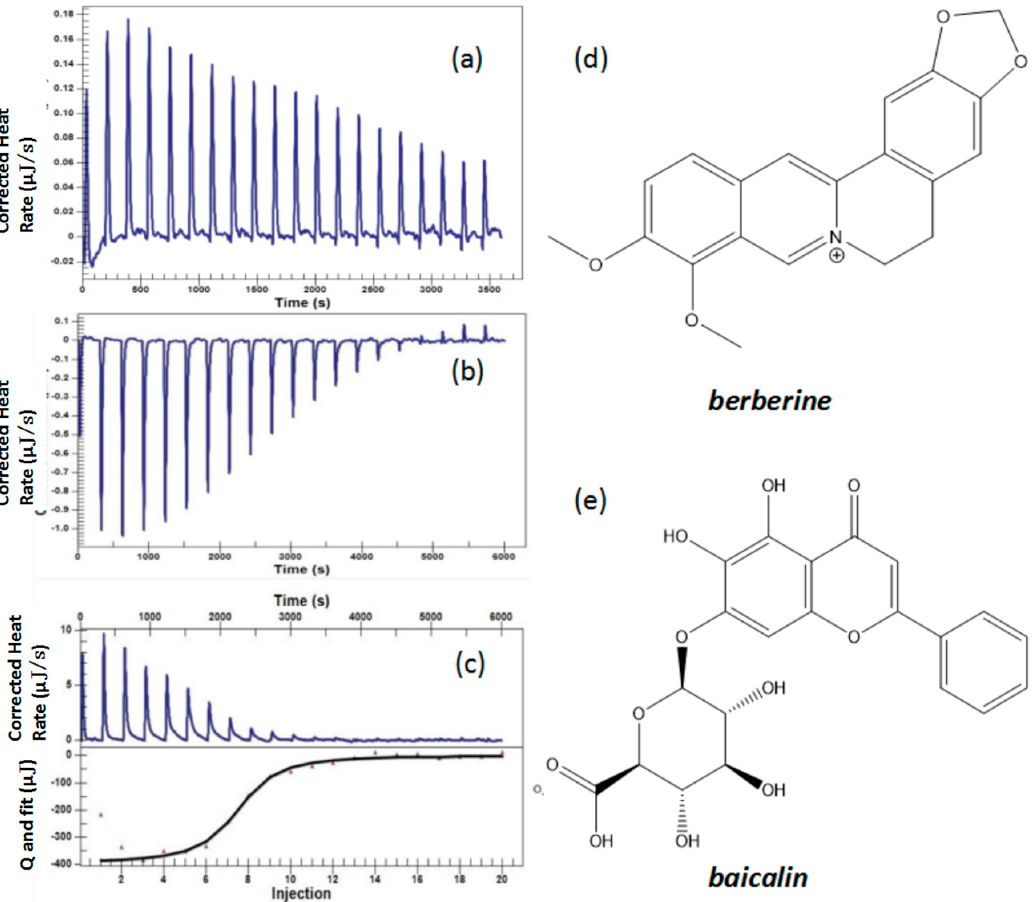
Figure 4. The reactive profiles of colliquefaction ( a ) Calorimetric titration of deionized water with 0.04 mmol/L baicalin solution; ( b ) Calorimetric titration of deionized water with 0.4 mmol/L berberine solution; ( c ) Clorimetric titration of 0.04 mmol/L baicalin solution with 0.4 mmol/L berberine solution and the heating curve of baicalin solution titrated by berberine solution; ( d ) Structure of berberine; ( e ) Structure of baicalin.